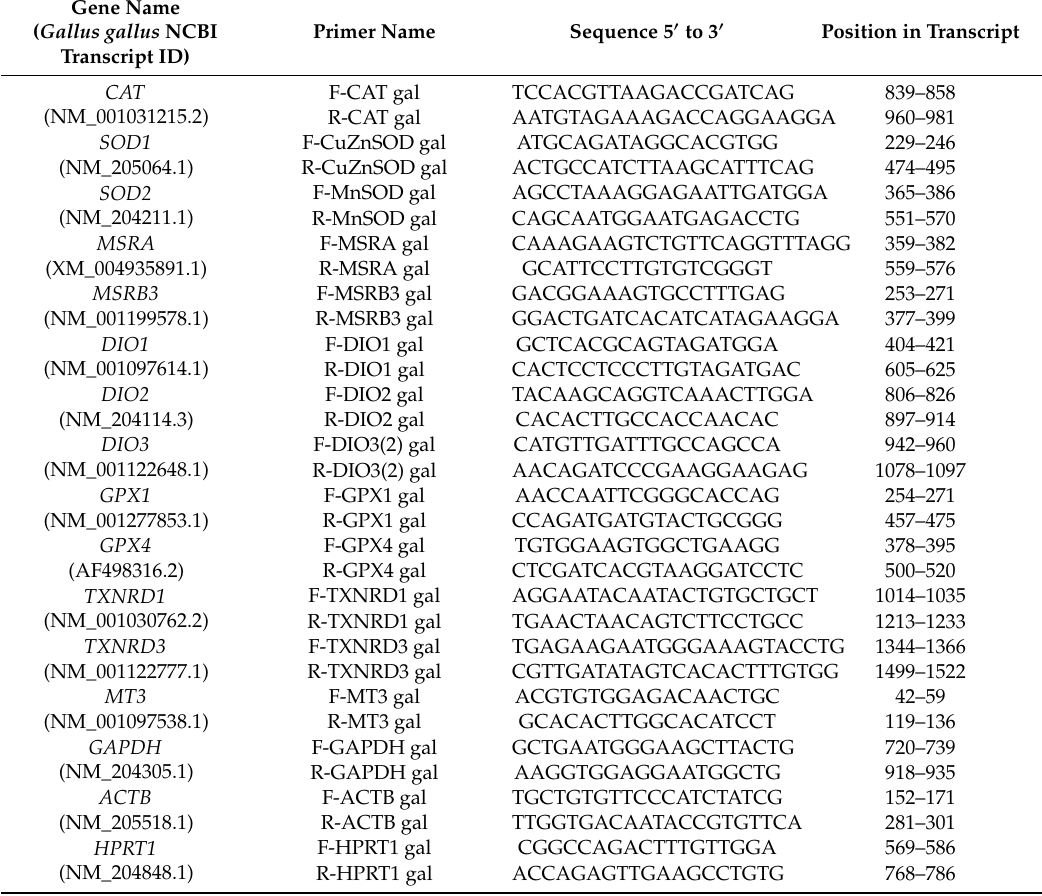
Table 2. Sequences and relative positions of forward (F) and reverse (R) primers for catalase (CAT), superoxide dismutase 1 (SOD1) and 2 (SOD2), methionine sulfoxide reductase A (MSRA) and B3 (MSRB3), iodothyronine deiodinase 1 (DIO1), 2 (DIO2), and 3 (DIO3), glutathione peroxidase 1 (GPX1) and 4 (GPX4), thioredoxin reductase 1 (TXNRD1) and 3 (TXNRD3), metallothionein 3 (MT3), glyceraldehyde 3-phosphate dehydrogenase (GAPDH), β -actin (ACTB), and